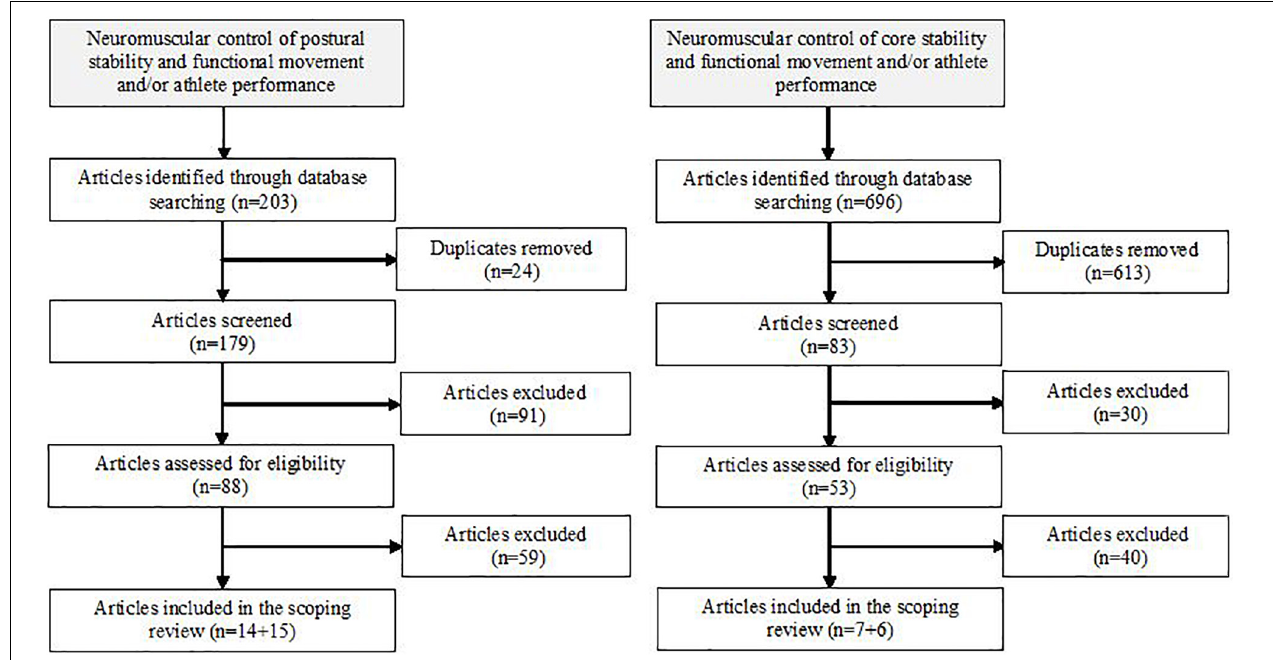
FIGURE 1 | Flow chart showing the literature search